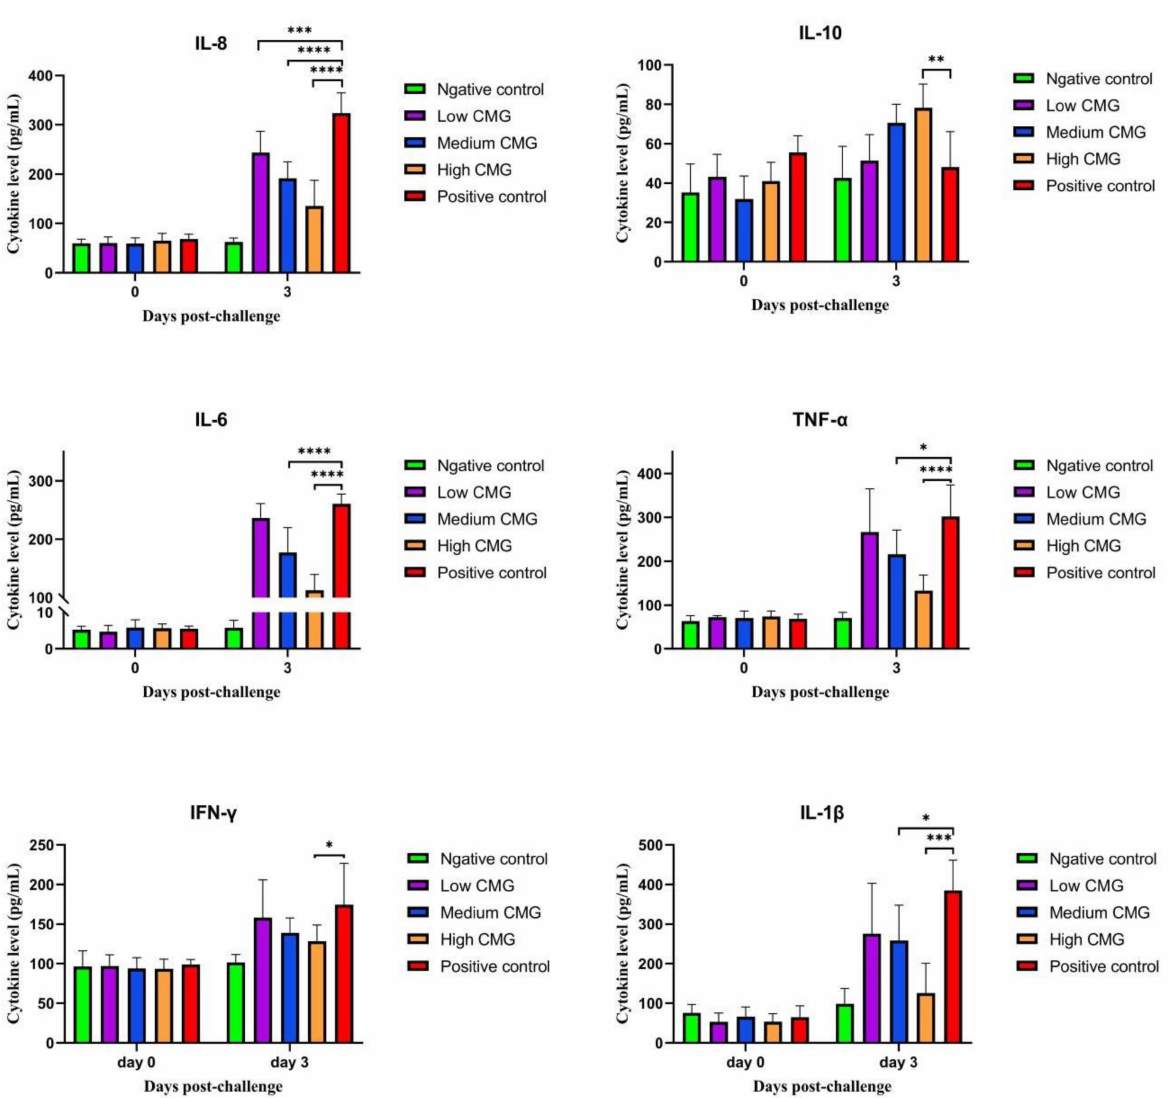
Figure 6. Effects of caprylic monoglyceride on cytokine (IL-6, IL-8, IL-IL-0, IL-1 β , IFN- γ , TNF- α ) levels in blood. Shows the changes in cytokine levels at 0 dpi and 3 dpi and a comparison of cytokine levels among the five groups of piglets at 3 dpi. Statistical significance is denoted by * p < 0.05, ** p < 0.01, *** p < 0.001, **** p <